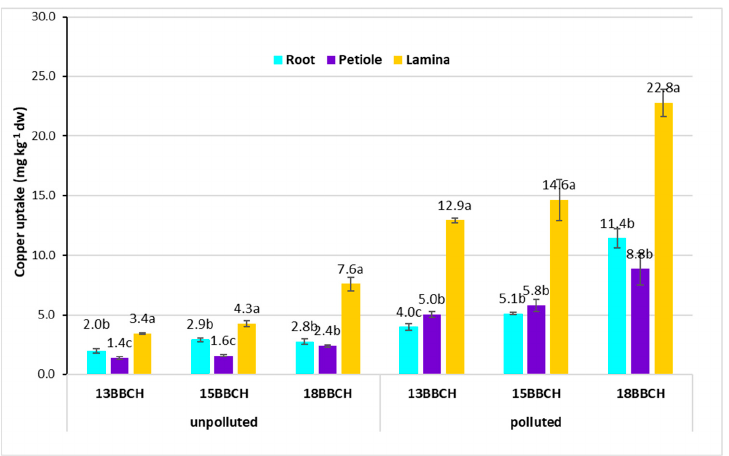
Figure 4. Cu uptake in S. perfoliatum organs for different development stages when grown in heavy metal Ps and Us. Error bars represent SE. Different letters (a–c) indicate significant differences ( p < 0.05) between plant organs.